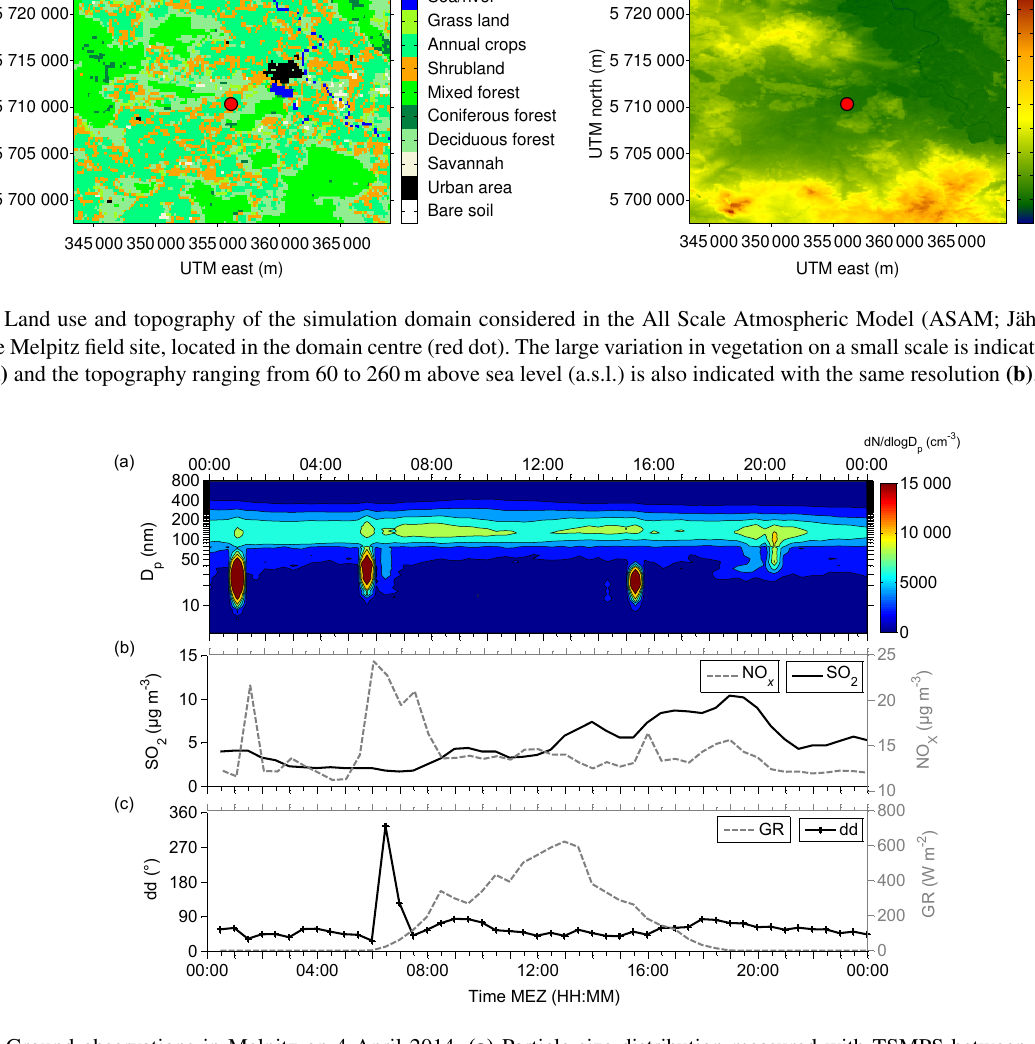
Figure 2. Ground observations in Melpitz on 4 April 2014. (a) Particle size distribution measured with TSMPS between 3 and 800nm, (b) gas concentrations of SO 2 and NO x , (c) wind direction dd and global radiation GR. More information on ground instrumentation can be taken from Wiedensohler et al. (2012) and Hamed et al.